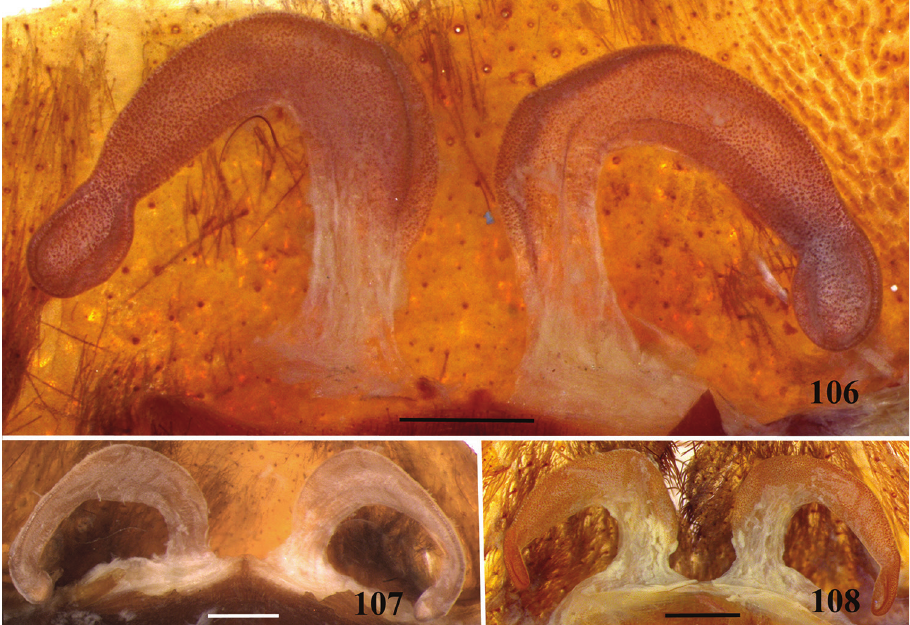
Figures 106–108. Avicularia juruensis Mello-Leitão, 1923, spermathecae variation. 106 paralectotype, Rio Juruá, state of Amazonas, Brazil (MZUSP 125C) 107 paralectotype, Rio Juruá, state of Amazonas, Brazil (MZUSP 125A) 108 morphotype 3, Pebas, department of Loreto, Peru (MNHN–AR 4902). Scale bars = 1